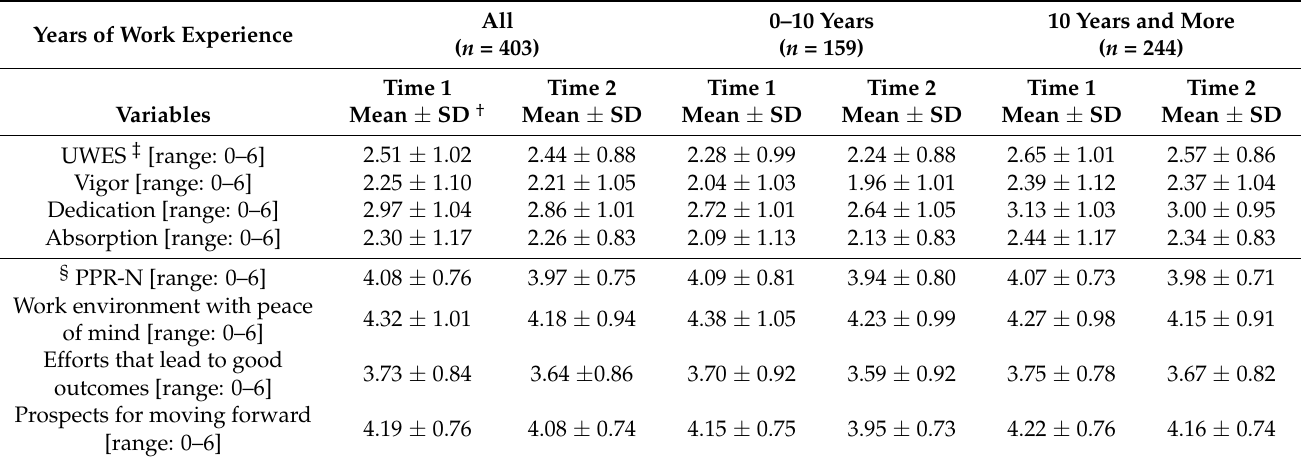
Table 2. Descriptive statistics for work engagement and personal and professional resources for nurses to work vigorously by years of work